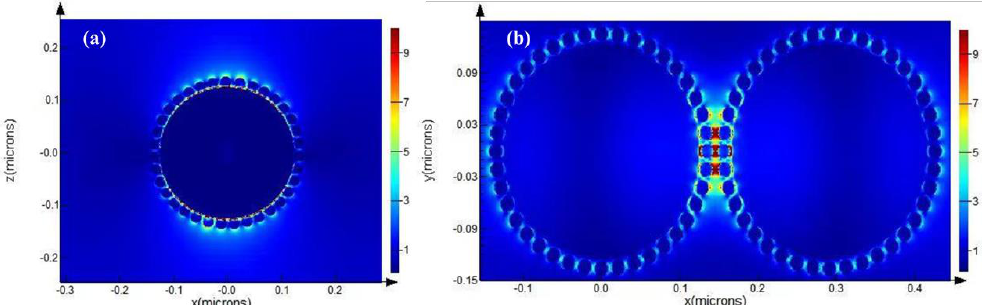
Figure 6. Digital FDTD simulation: ( a ) SERS effect simulation of single GO/Fe 3 O 4 @Au MNPs; ( b ) SERS effect simulation of two GO/Fe 3 O 4 @Au MNPs at D = 1 nm (graphene was placed between the two spheres).